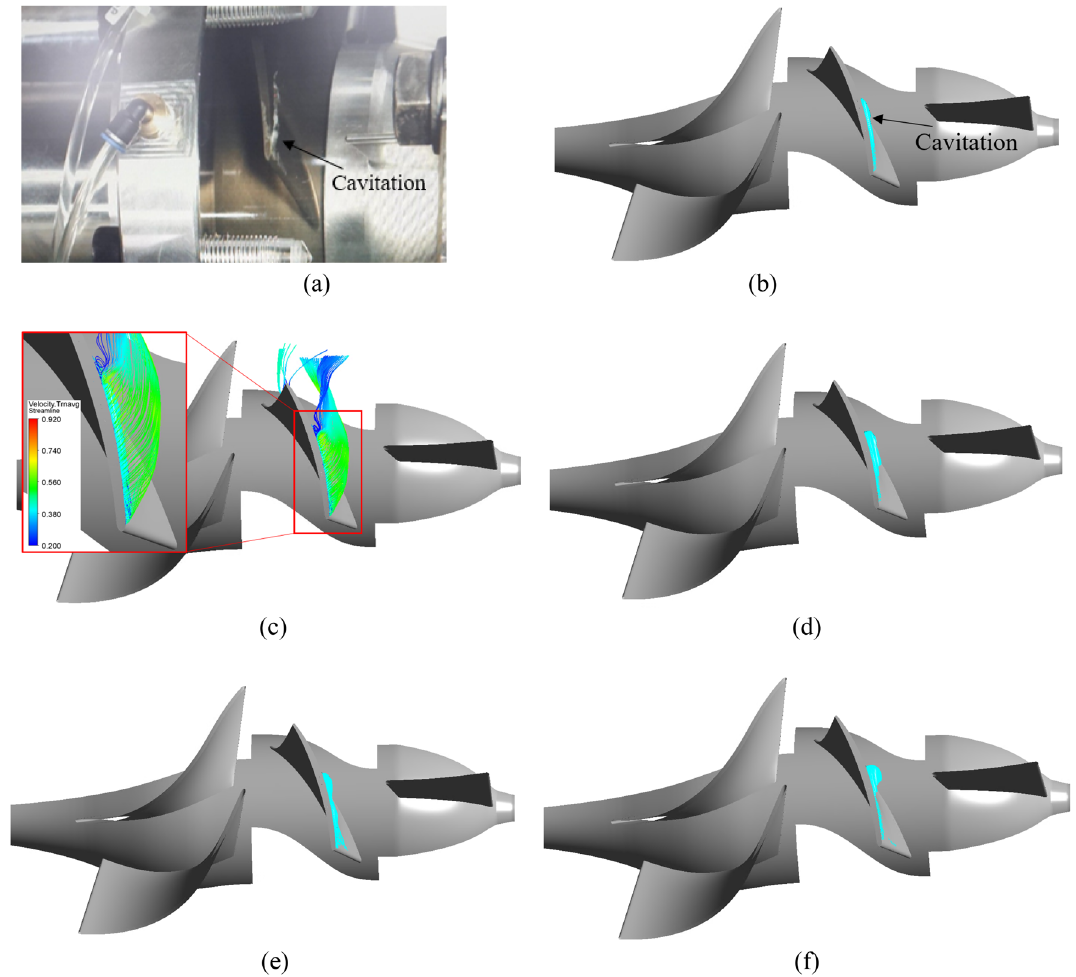
Figure 14. Internal flow comparison of experiment with different flow intensities in numerical result at 0.85 ϕ d